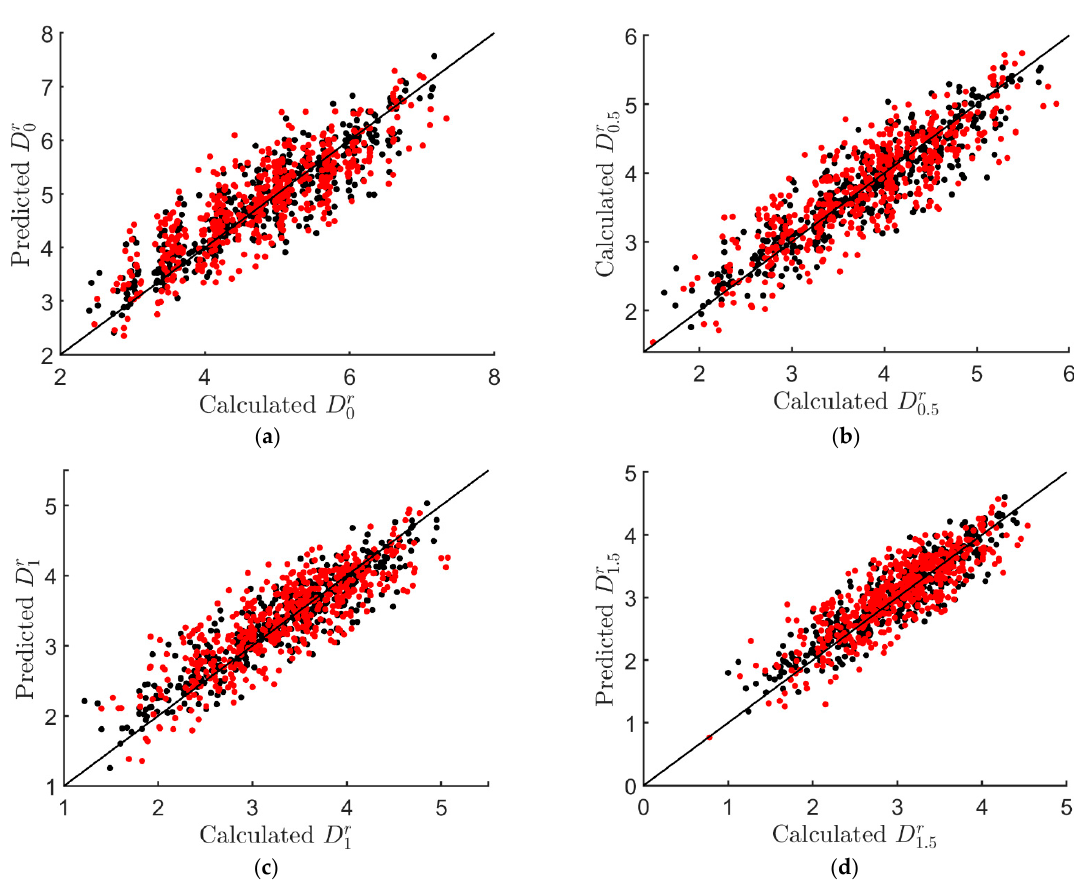
Figure 25. Predictions of runout from the numerical simulations and the machine-learning model (black dots = training; red dots = validation): ( a ) MAPE = 9.45% with 𝐷 (cid:2868)(cid:3045) ; ( b ) MAPE = 9.24% with 𝐷 (cid:2868).(cid:2873)(cid:3045) ; ( c ) MAPE = 10.03% with 𝐷 (cid:2869)(cid:3045) ; ( d ) MAPE = 10.04% with 𝐷 (cid:2869).(cid:2873)(cid:3045) .